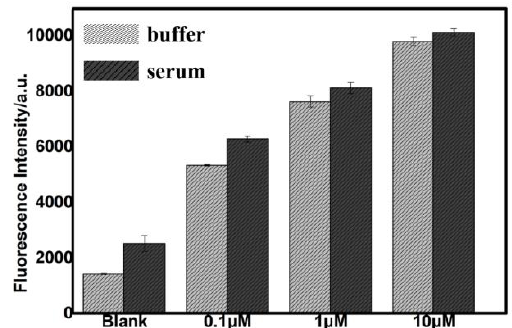
Figure 5. Results obtained from the fluorescent tests of diluted serum samples spiked with di ff erent concentrations of thrombin and thrombin in bu ff er. The same reaction mixtures without thrombin were used as the blank group. The error bar was calculated from three independent experiments. Table 3. Recovery tests in actual samples.